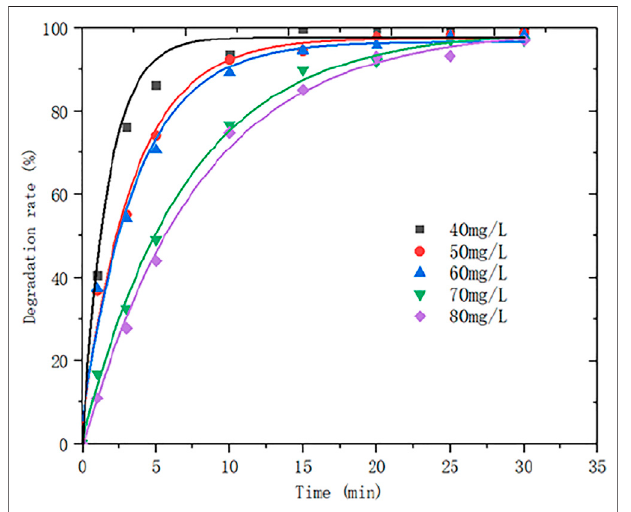
FIGURE8| EffectofMBsolutionconcentrationonMBdegradationrate. FIGURE 9 | Effect of pH on MB degradation rate.